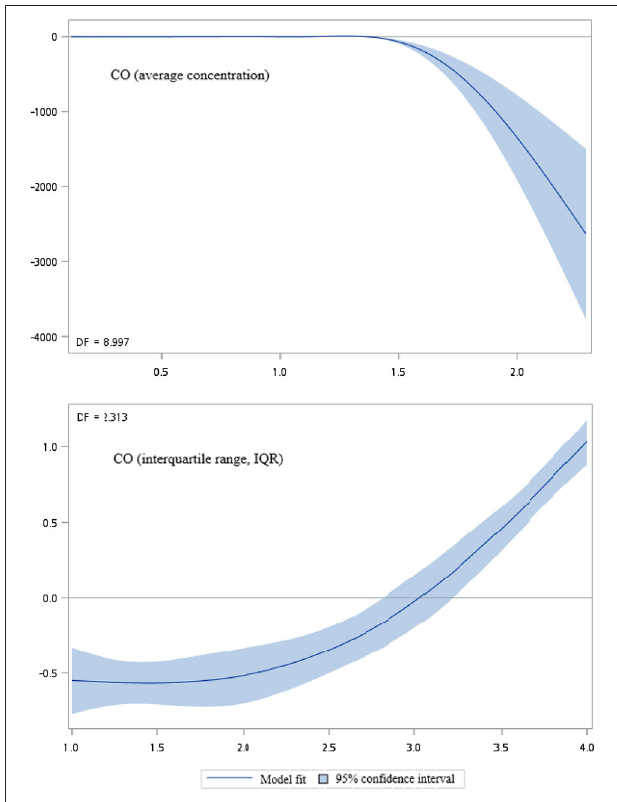
FIGURE 5 | Generalized additive model plot for air pollutions (CO).